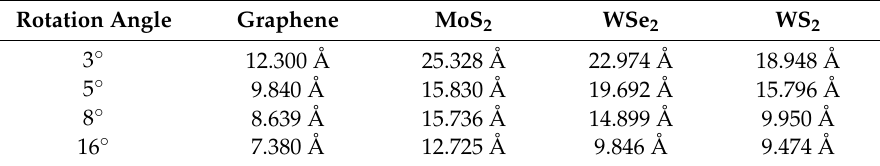
Figure 5. HRTEM simulation for ( a ) 3°; ( b ) 5°; ( c ) 8° and ( d ) 16° of rotation in tungsten diselenide molecular structure. Table 1. O-lattice distribution for 2D layered materials corresponding to molecular structures at various rotation angles.